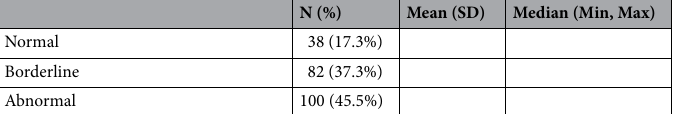
Table 1. Socio-demographic and health variables of the study participants ( N = 220). HS-CRP high-sensitivity C-reactive protein, HbA1c hemoglobin A1c.